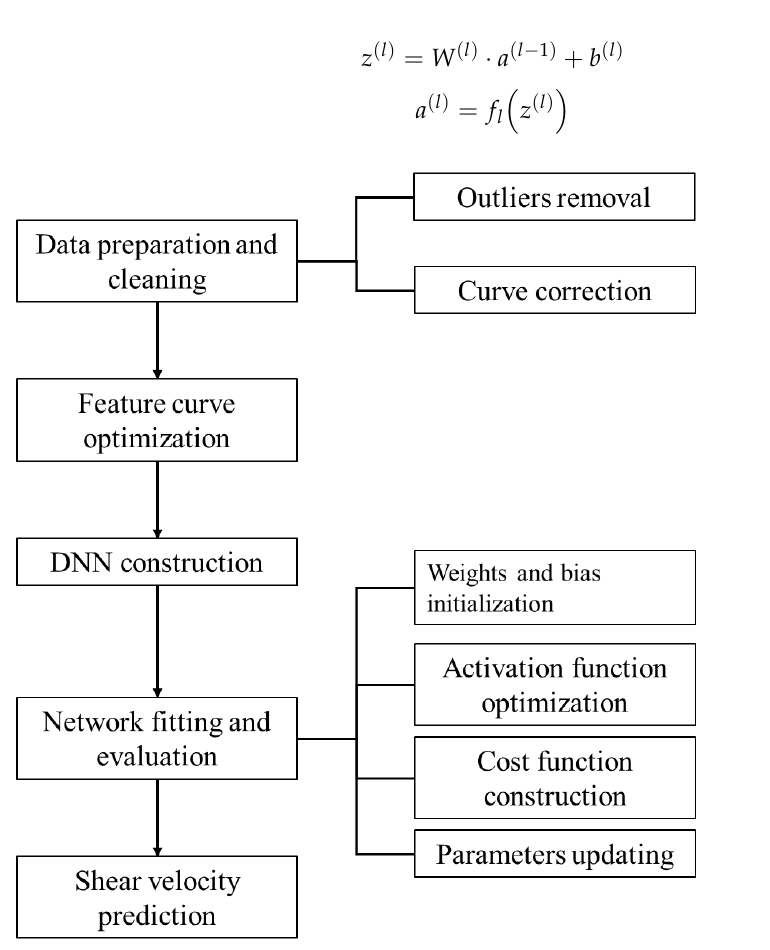
Figure 5. The workflow shows the necessary steps adopted to complete the